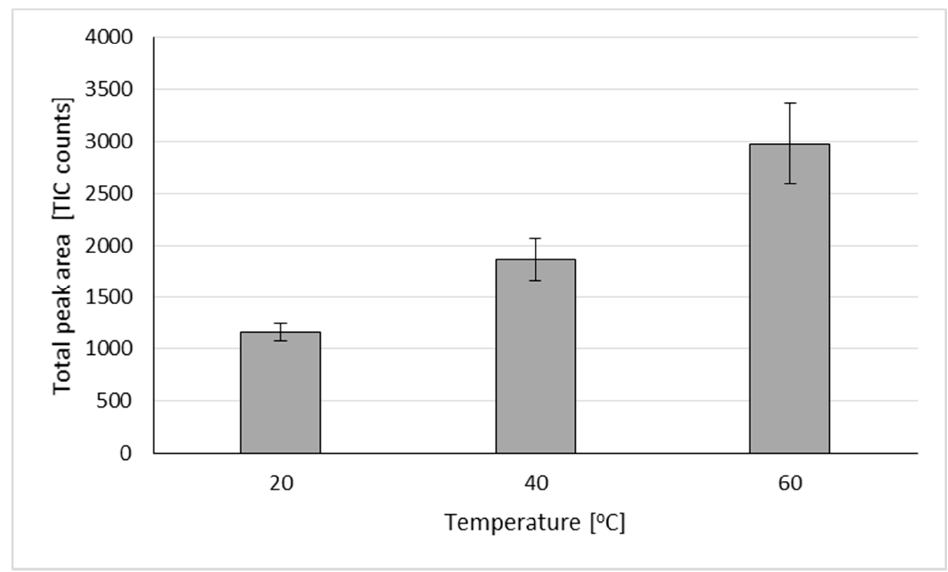
Figure 2. Total peak areas of terpenes extracted from cold pressed coriander oil using VASE at different extraction temperatures. All extractions were performed for 5 min; total peak areas expressed in million counts.